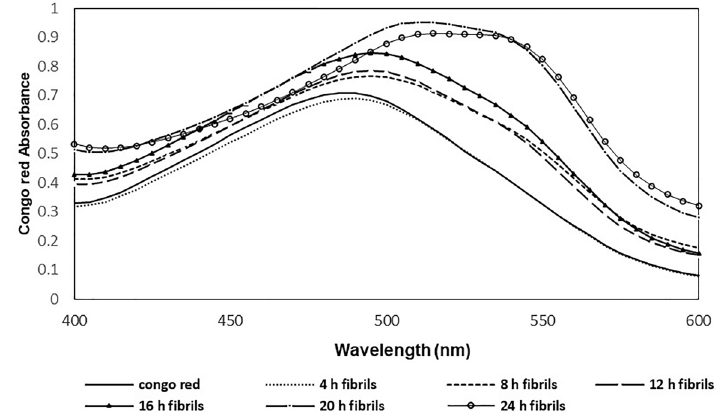
Figure 2. Congo red absorption spectrum of incubated insulin at 4, 8, 12, 16, 20, and 24 h.